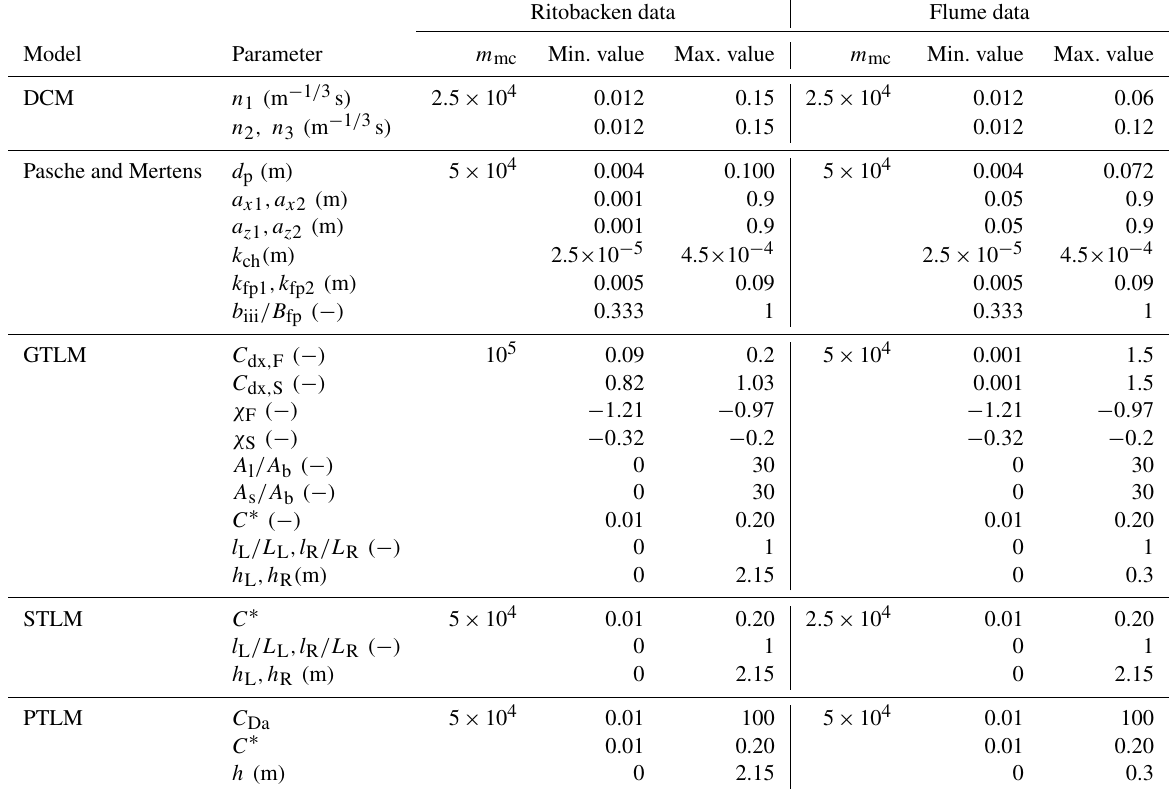
Table 1. Parameter variability ranges (uniform P (θ) distribution) for the Ritobacken and flume experiments; numerals in parameter symbols are used to distinguish properties on the left (1) and right (1) channel